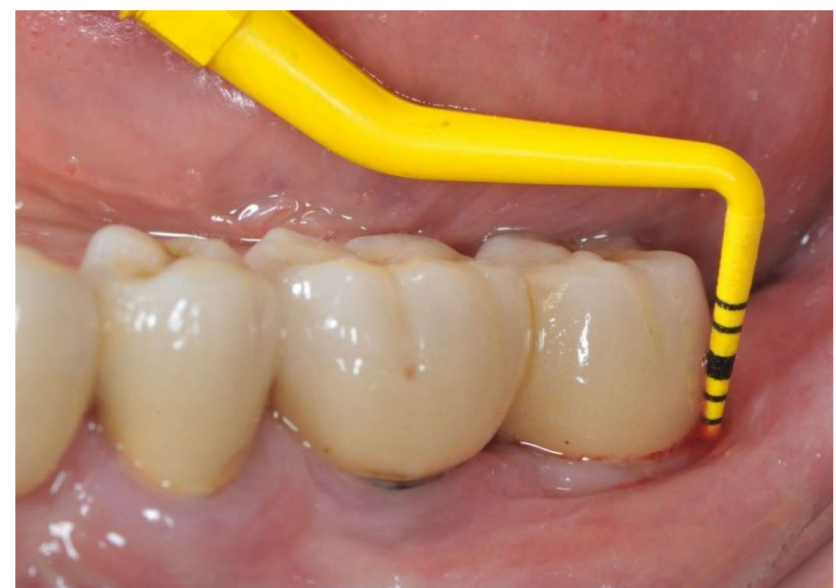
Figure 1. Buccal view before peri-implant therapy: bleeding on probing and probing depth of 7 mm around the distal implant.